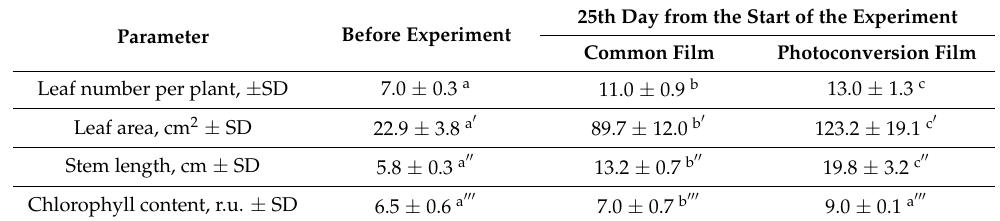
Table 1. Effect of an upconversion luminescent film on the growth of tomatoes. Presented data are the result of averaging from four (leaf area) to eleven (all other parameters) measurements.